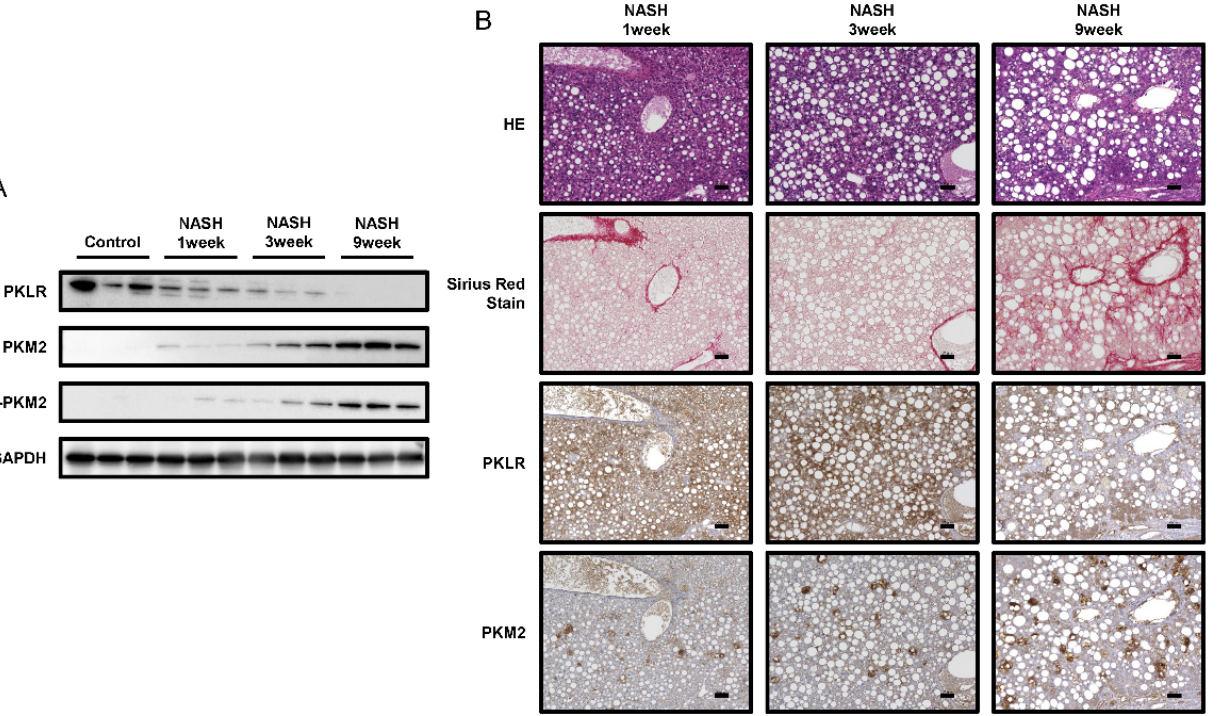
Figure 4. Changes in PK enzyme expression in the early-phase non-alcoholic steatohepatitis (NASH) mouse model. ( A ) Protein expression levels of PKLR, PKM2, and phosphorylated PKM2 (p-PKM2) in the liver of control and NASH mice after 1, 3, and 9 weeks ( n = 3). GAPDH was used as an internal control. ( B ) Images of each staining. Upper panels, HE; 2nd panels, Sirius Red staining; 3rd panels, PKLR; lower panels, PKM2. Scale bars = 50 µm.